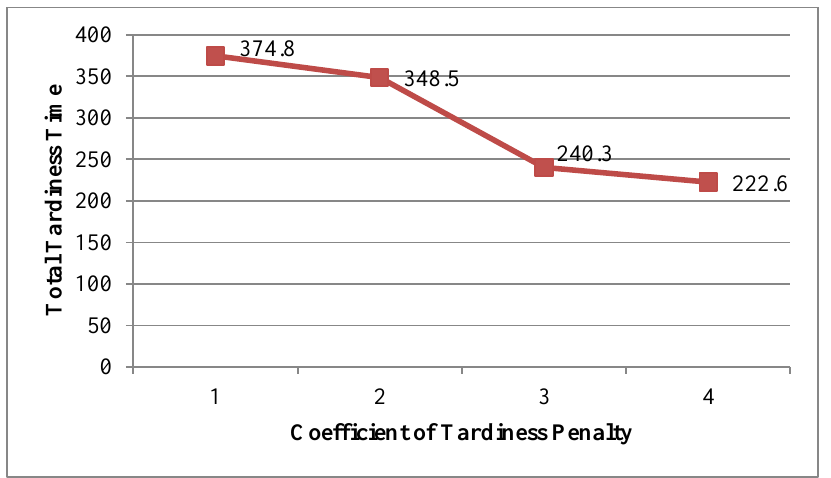
Fig. 3. The effect of increasing tardiness penalties on total tardiness time